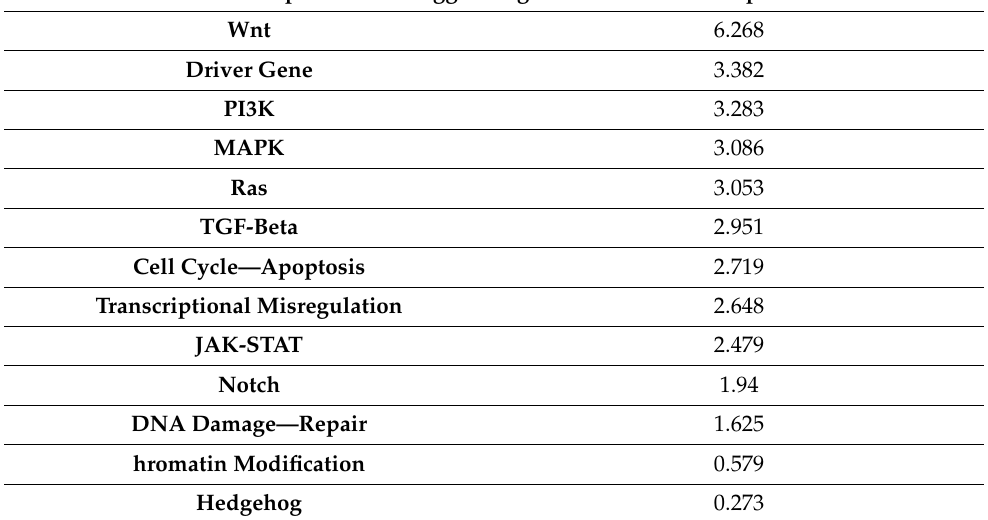
Table 3. Global significance ratings comparing overall differential expression of selected pathways relative to